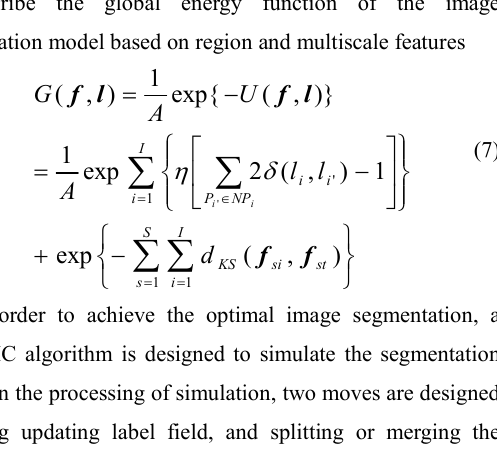
Figure 2 show the segmentation results of two real SAR images. From Figure 2, it can be found that the proposed method can segment homogenous regions well. In order to qualitatively evaluate the segmentation results, overlaying the